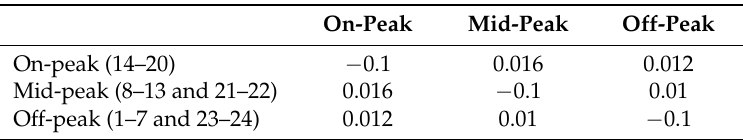
Table 4. Self- and cross-elasticity.